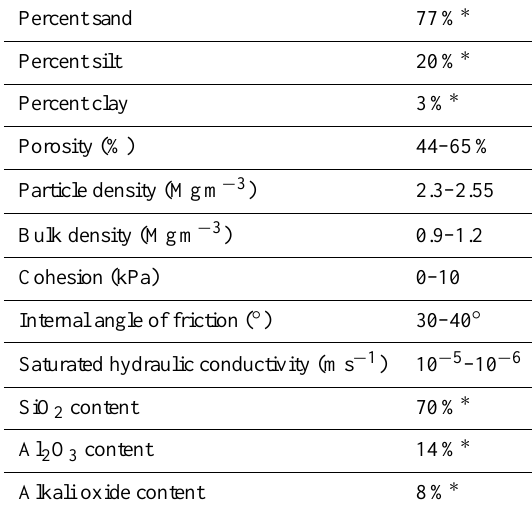
Table 1. Physical and mineralogical characteristics of Shirasu based on the following sources: Yokoyama (1970), Umehara et al. (1975), Nakano et al. (1981), Iwamatsu et al. (1989), Sugio and Okabayashi (1994), Sako et al. (2000), Chigira and Yokoyama (2005), Hira et al. (2006), and Takewaka (2007). ∗ indicates average